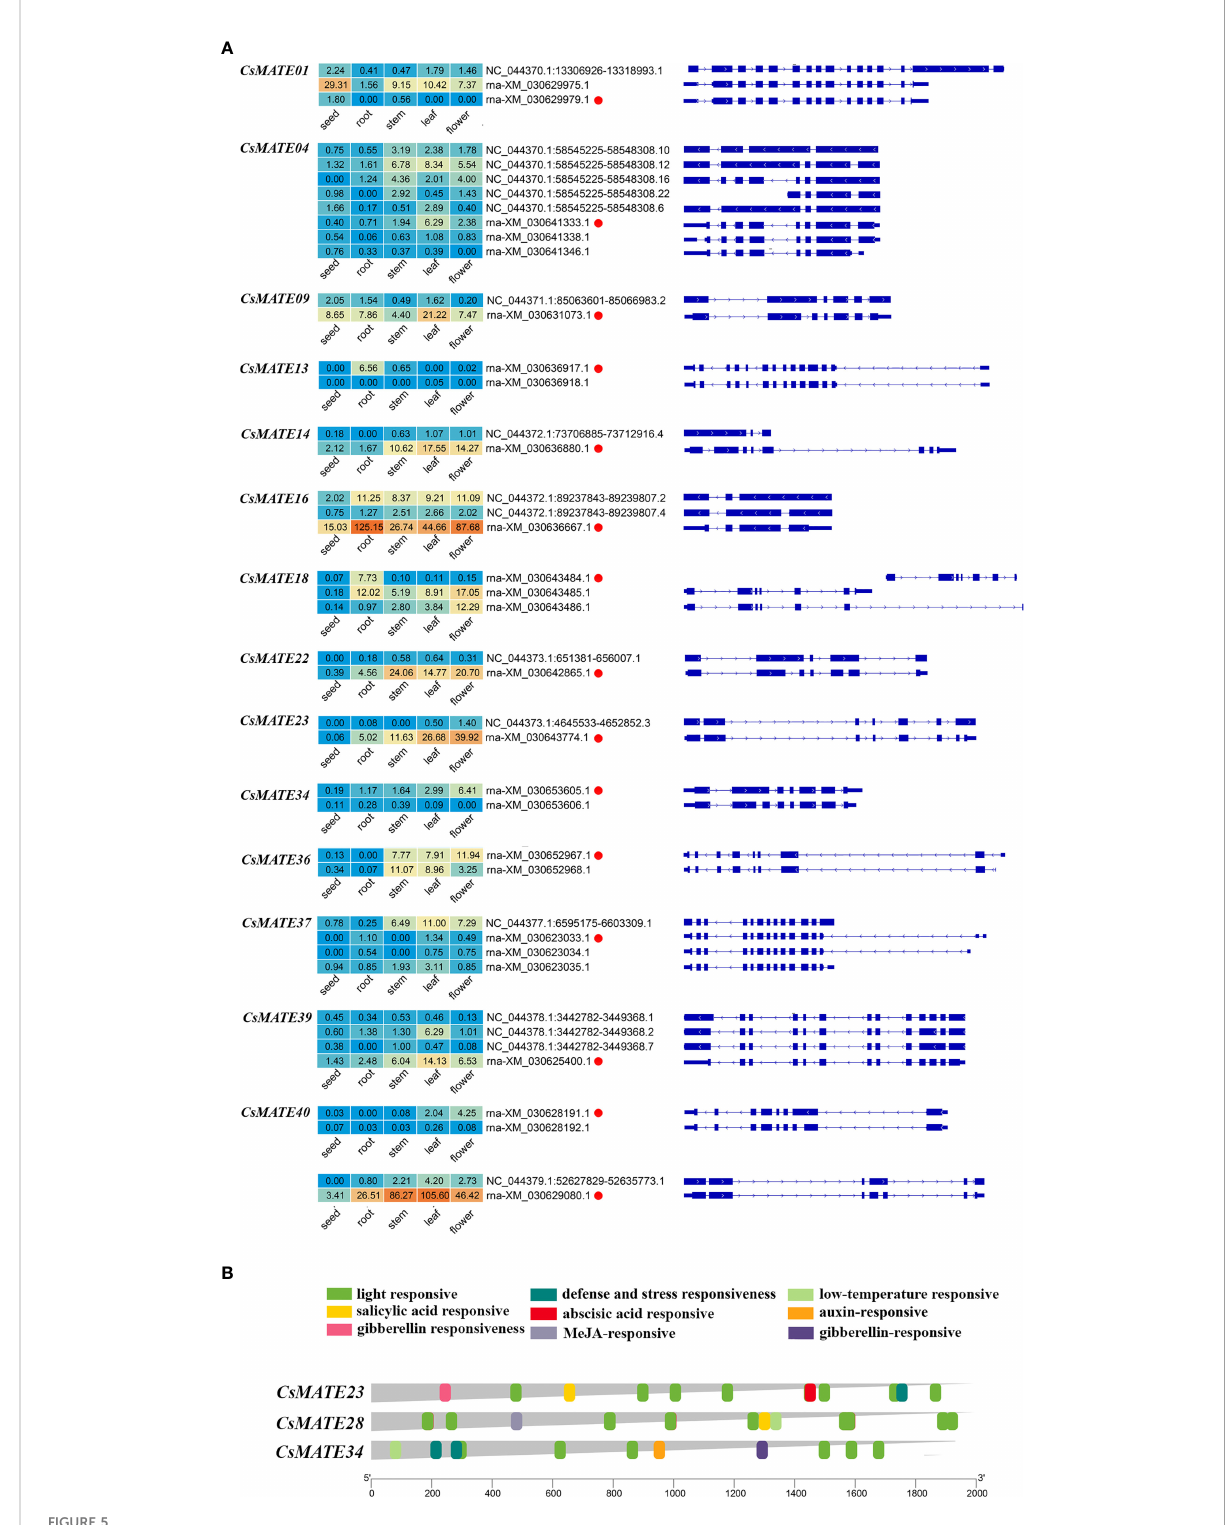
FIGURE 5 Expression of alternative splicing isoforms (A) and cis -acting elements in CsMATEs (B) . Red dots, alternative splicing isoform used for analysis in this study. Heatmap was con fi gured using PFKM value. Length of gene promoters in